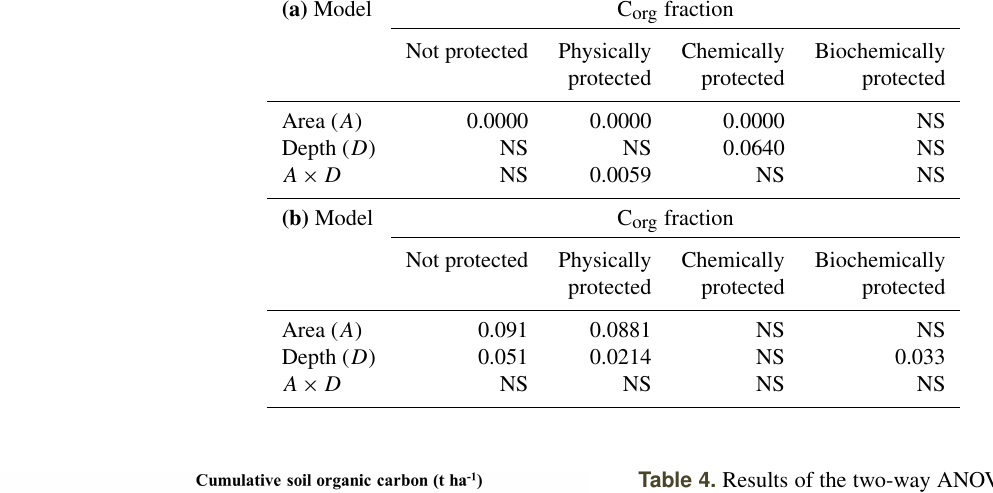
Table 4. Results of the two-way ANOVA of the stable isotope sig- nal. In (a) area refers to the reference site vs. the olive orchard, and in (b) area refers to eroded vs. deposition areas in the olive orchard. NS stands for not significant.